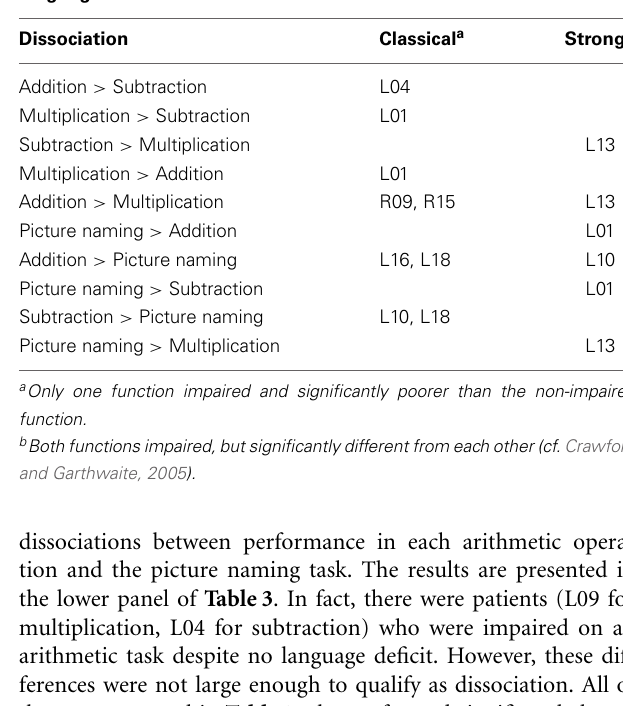
Table 3 | Patients with dissociations between arithmetic and language